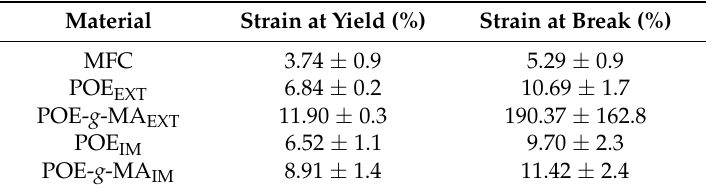
Table 4. Strain at break of the composites.